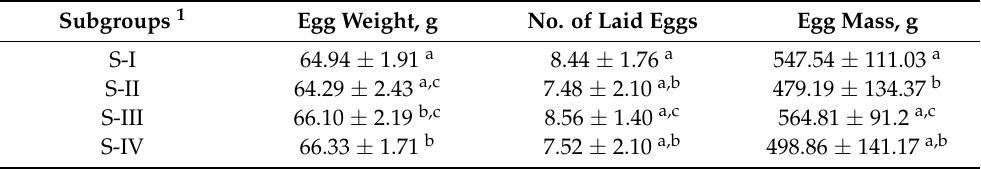
Table 2. Mean values of egg production traits by subgroup (M ±